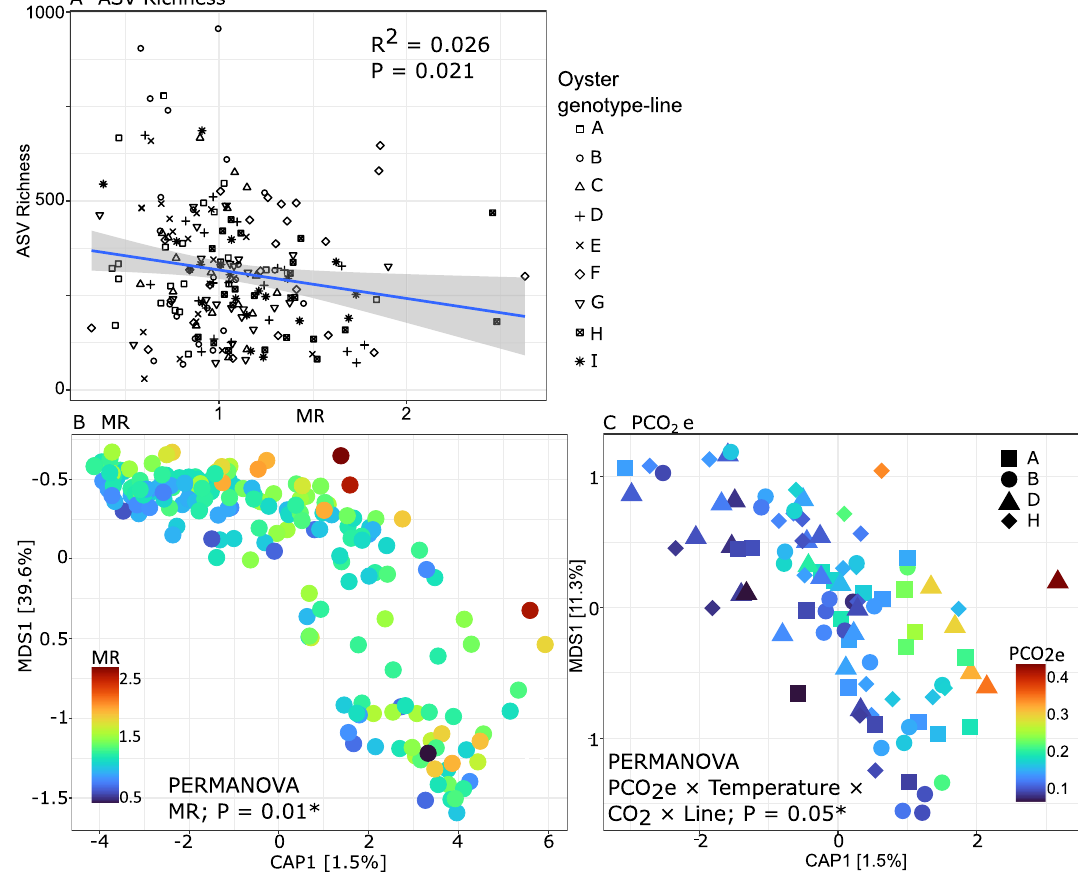
Figure 1. Relationships between microbial communities and physiological variables. ( A ) Relationship between the MR of oysters and ASV Richness. Blue line indicates linear tread (y ~ x) and grey shaded areas indicate 95% confidence intervals. Shapes represent different genotype-lines. Results from linear regression are shown. ( B ) CAP ordination of Weighted unifrac distances calculated from haemolymph oyster-associated bacterial community data. Colours represent MR corresponding to that haemolymph sample. CAP plots were constrained by the physiological variable on the x-axis and were not constrained on the y-axis. Results from PERMANOVA are shown. ( C ) CAP ordination of Weighted unifrac distances calculated from haemolymph oyster-associated bacterial community data. Shapes indicate the four families for which the microbiome was significantly affected by PCO 2e , colours represent haemolymph PCO 2e corresponding to that haemolymph sample. Results from PERMANOVA are